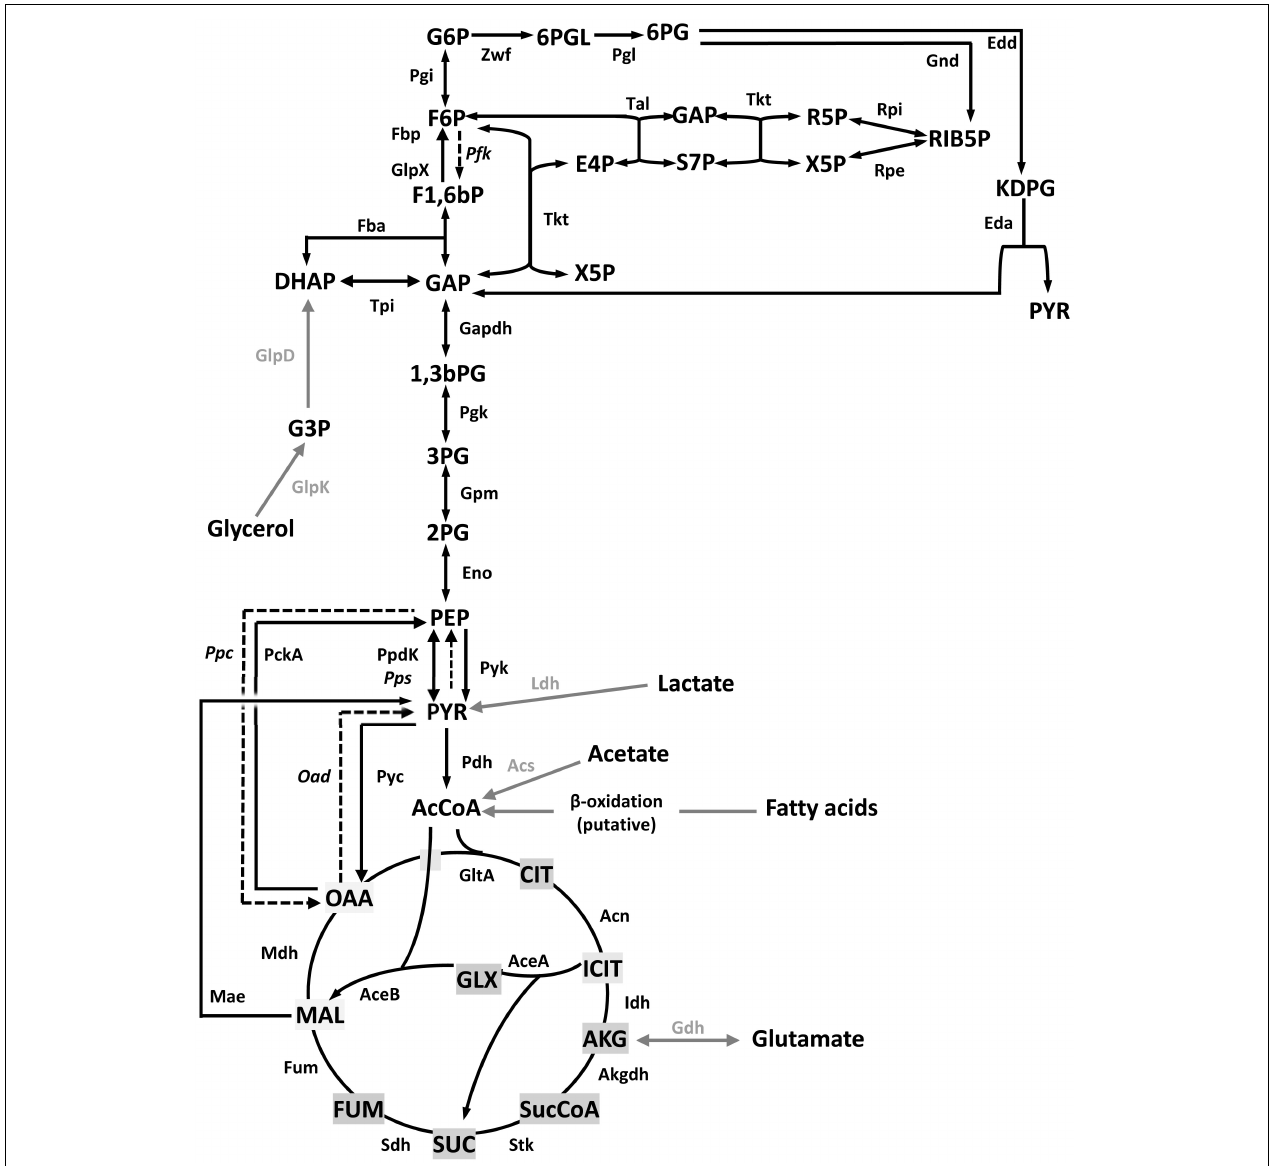
FIGURE 1 | Central C metabolic network of Brucella (adapted from Zúñiga-Ripa et al., 2014). The metabolic network includes complete pentoses phosphate, Entner–Doudoroff and gluconeogenesis pathways, as well as a complete tricarboxylic acid cycle including a glyoxylate shunt. The Embden–Meyerohof–Parnas pathway is interrupted due to the lack of phosphofructokinase (Pfk). Black dashed arrows and italics indicate steps for which no putative genes can be identified in Brucella Gray arrows and gray font indicate peripheral pathways. Metabolites: 1,3,bPG, 1,3-bisphosphoglycerate; KDPG, 2-keto-3- deoxy-phosphogluconate; 2PG, 2-phosphoglycerate; 3PG, 3-phosphoglycerate; 6PGL, 6-P-gluconolactone; 6PG, 6-phosphogluconate; AcCoA, acetyl-coenzyme A; AKG, alpha-ketoglutarate; CIT, citrate; ICIT, isocitrate; DHAP, dihydroxyacetone-phosphate; E4P, erythrose-4-phosphate; F1,6bP, fructose-1,6-bisphosphate; F6P, fructose-6-phosphate; FUM, fumarate; G6P, glucose-6-P; GAP, glyceraldehyde-3-phosphate; G3P, glycerol-3-phosphate; GLX, glyoxylate; MAL, malate; OAA, oxaloacetate; PEP, phosphoenolpyruvate; PYR, pyruvate; R5P, ribose-5-P; RIB5P, ribulose-5-P; S7P, sedoheptulose-7-P; SUC, succinate; SucCoA, succinyl-coenzyme A; X5P, xylulose-5-P. Enzymes: Edd, 6-phospho- D -gluconate dehydratase; Gnd, 6-phosphogluconate dehydrogenase; Pgl, 6-phosphogluconolactonase; Acs, acetyl-coenzyme A synthetase; Acn, aconitate hydratase; Akgdh, alpha-ketoglutarate dehydrogenase; GltA, citrate synthase; eno, enolase; Fbp, GlpX, fructose-1,6-bisphosphatase; Fba, fructose bisphosphate aldolase; Fum, fumarase; Zwf, glucose-6-phosphate dehydrogenase; Pgi, glucose-6-phosphate isomerase; Gdh, glutamate dehydrogenase; Gapdh, glyceraldehyde-3-phosphate dehydrogenase; GlpD, glycerol-3-phosphate dehydrogenase; GlpK, glycerol kinase; Idh, isocitrate dehydrogenase; AceA, isocitrate lyase; Eda, 2-dehydro-3-deoxy-phosphogluconate aldolase; Ldh, lactate dehydrogenase; Mdh, malate dehydrogenase; AceB, malate synthase; Mae, malic enzyme; PckA, phosphoenolpyruvate carboxykinase; Ppc, phosphoenolpyruvate carboxylase; Pps, phosphoenolpyruvate synthase; Pfk, phosphofructokinase; Pgk, phosphoglycerate kinase; Gpm, phosphoglycerate mutase; Oad, pyruvate carboxykinase; Pyc, pyruvate carboxylase; Pdh, pyruvate dehydrogenase; Pyk, pyruvate kinase; PpdK, pyruvate phosphate dikinase; Rpi, ribose-5-phosphate isomerase; Rpe, ribulose-5-phosphate-3-epimerase; Sdh, succinate dehydrogenase; Stk, succinyl-coenzyme A synthethase; Tal, transaldolase; Tkt, transketolase; Tpi, triose phosphate isomerase.